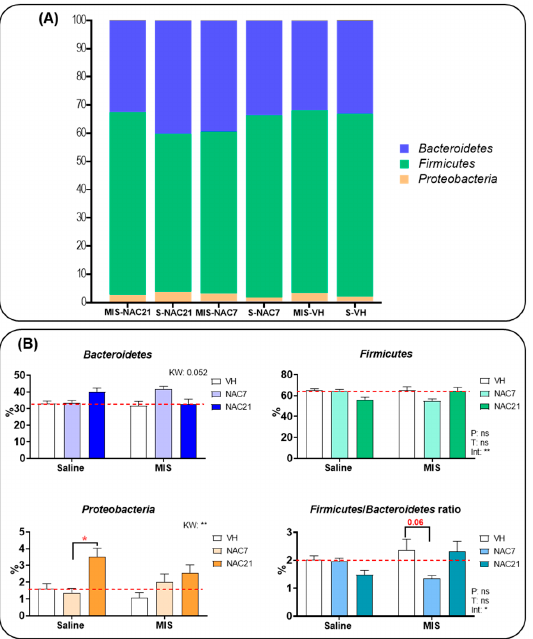
Figure 2. ( A ) The nested bar at the phylum level. The nested bar graph shows the mean percentage composition of the most representative phyla for each group. Bacteroidetes (purple), Firmicutes (green) and Proteobacteria (orange) were the most common phyla. ( B ) Gut microbiota composition at the phylum level. Graphs show the mean percentage composition of the 3 most representative phyla and the Firmicutes/Bacteroidetes ratio in the Saline and MIS animals treated with NAC during gestation. (Saline VH, N = 8; Saline NAC7, N = 11; Saline NAC21, N = 11; MIS VH, N = 11; MIS NAC7, N = 11; MIS NAC21, N = 11). Data are shown as mean ± SEM. 2-way ANOVAs followed by Tukey posthoc test or Kruskal–Wallis (KW) analysis followed by Dunn(cid:31)s multiple comparison are shown (* p < 0.05, ** p < 0.01) [ns: non-signi fi cant, P: Phenotype, T: Treatment, int: Interaction]. The red do tt ed line indicates the mean value of the control group (Saline-VH).